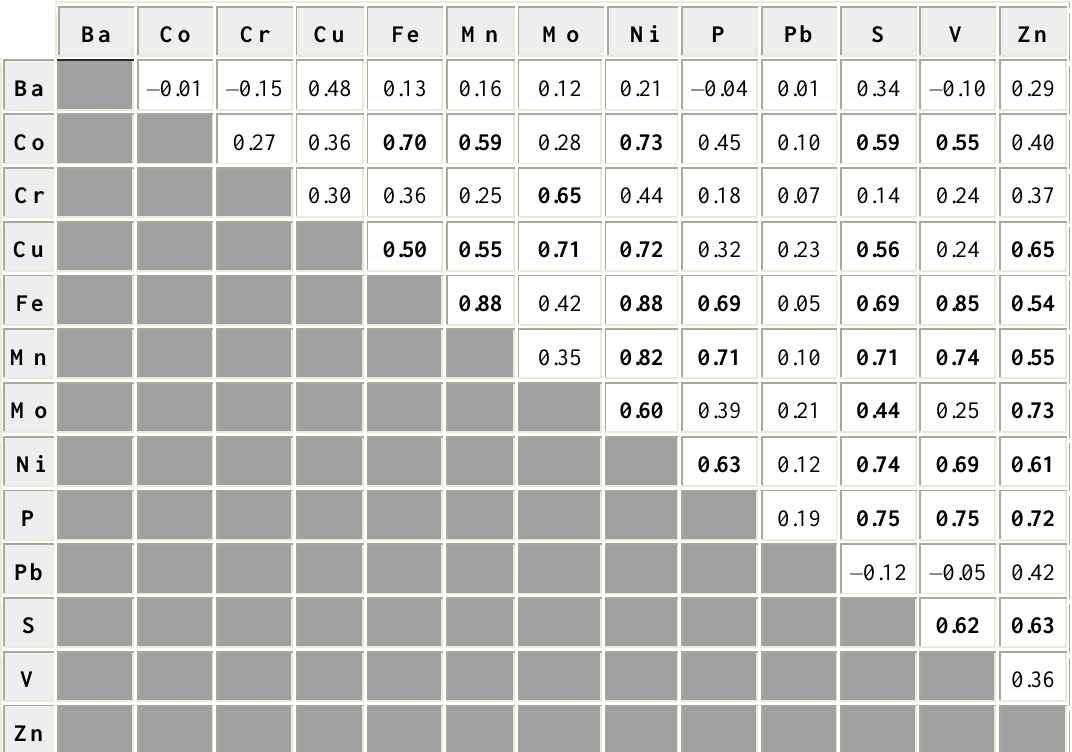
Table 2. Matrix of Spearman Rank Correlations of all available analyzed elements in road dust in Downtown Atlanta, GA,